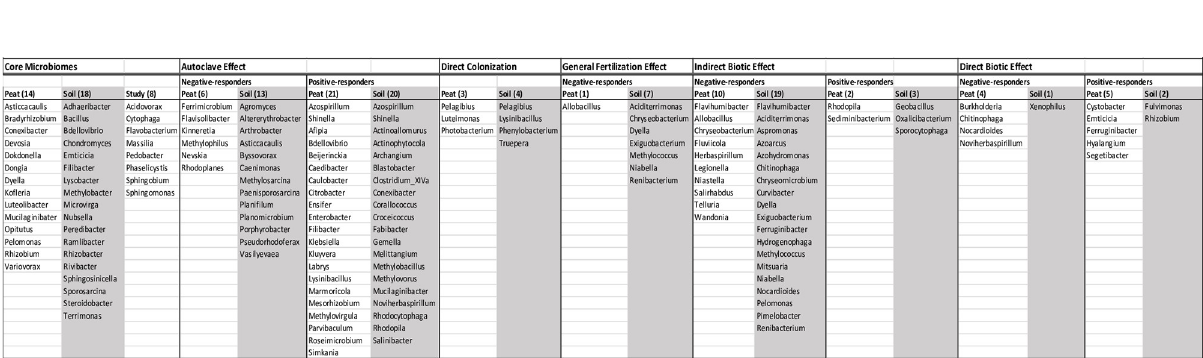
Fig 4. Potential patterns of taxa presence/absence across treatments. Summary of genus presence/absence across treatments grouped by potential response bin. Soil rhizosphere taxa are shaded in gray. Genera present in both peat and soil rhizospheres for a given bin are listed first with all other genera listed alphabetically